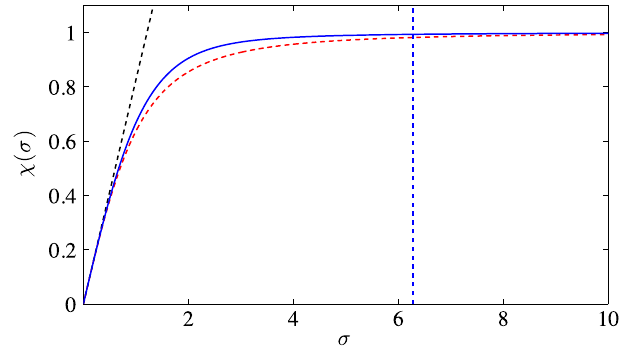
FIG. 1. Amplitude of the wave function for a single-vortex solution of the Gross-Pitaevskii equation. The numerical solu- tion of (22) (solid line) is compared with the ansatz (44) (dashed line). The inclined dashed line shows the slope (cid:3) of the exact solution at the origin. The vertical line is the point (cid:13) ¼ 2 (cid:5)